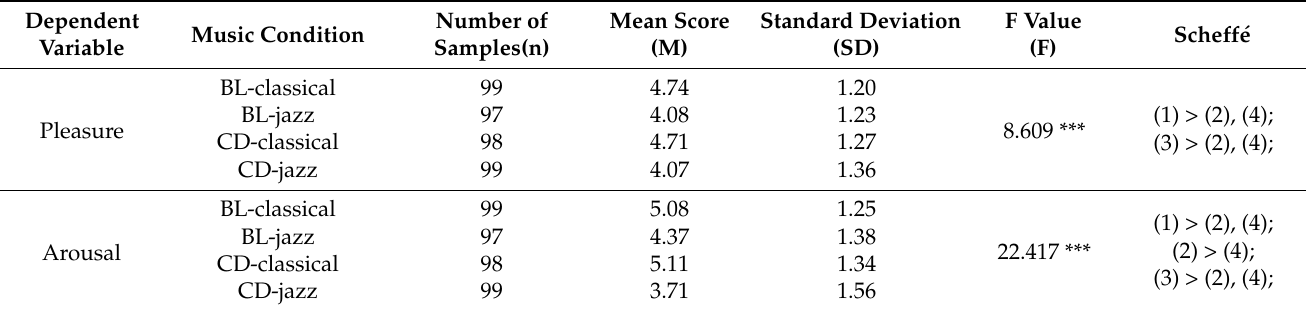
Table 6. One-factor ANOVA of the emotions during the dining experience under different music conditions ( n = 393).